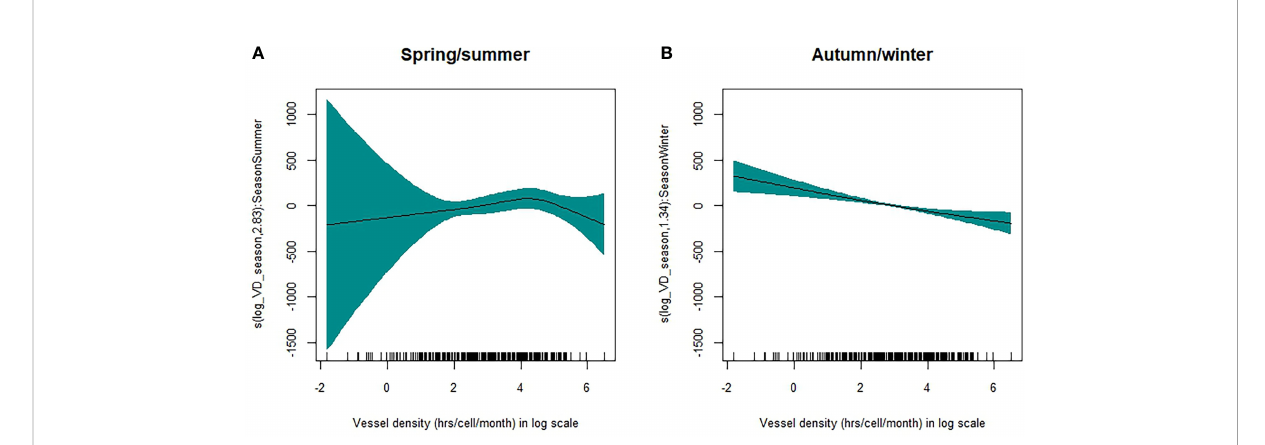
FIGURE 7 GAM plots show the effect of the smooth terms (vessel densities) and linear terms (seasonality) in the model, with reference to Spring/summer (A) and Autumn/winter (B) seasons. Results are in log scale. The blue shades show the 95% con fi dence interval for the mean shape of the effect. Data points are represented by the black vertical lines at the bottom of the